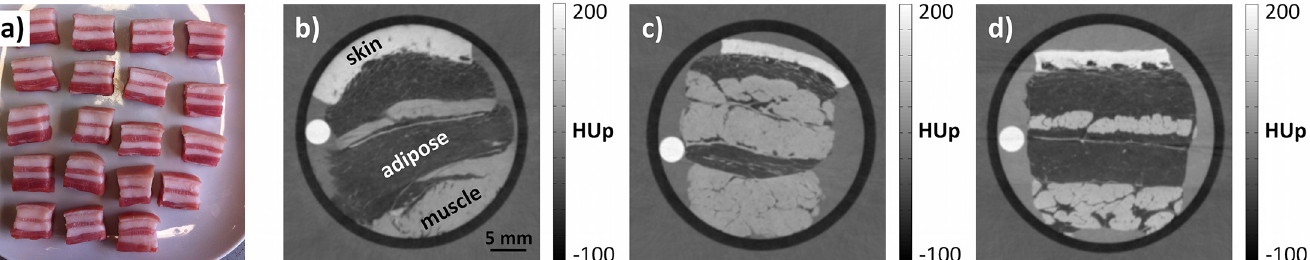
Fig 2. Representative phase-contrast imaging results of non-fixated and fixated tissue samples. (a) Photograph of porcine fat and rind samples on which the effects of formalin fixation were investigated (note the presence of skin, muscle and adipose tissues). Samples were immersed in physiological saline or fixated with formaldehyde solutions of varying concentrations. (b) Phase-contrast axial slice through a non-fixated porcine sample. Skin, muscle and adipose tissues are clearly differentiated by their signal intensities. (c) Phase-contrast image of a sample fixated in typical preservation solution (containing 3.7% formaldehyde). (d) Phase-contrast image of a sample fixated in 18.5% formaldehyde solution. The signal intensities in b) are visually indistinguishable from those of (c).